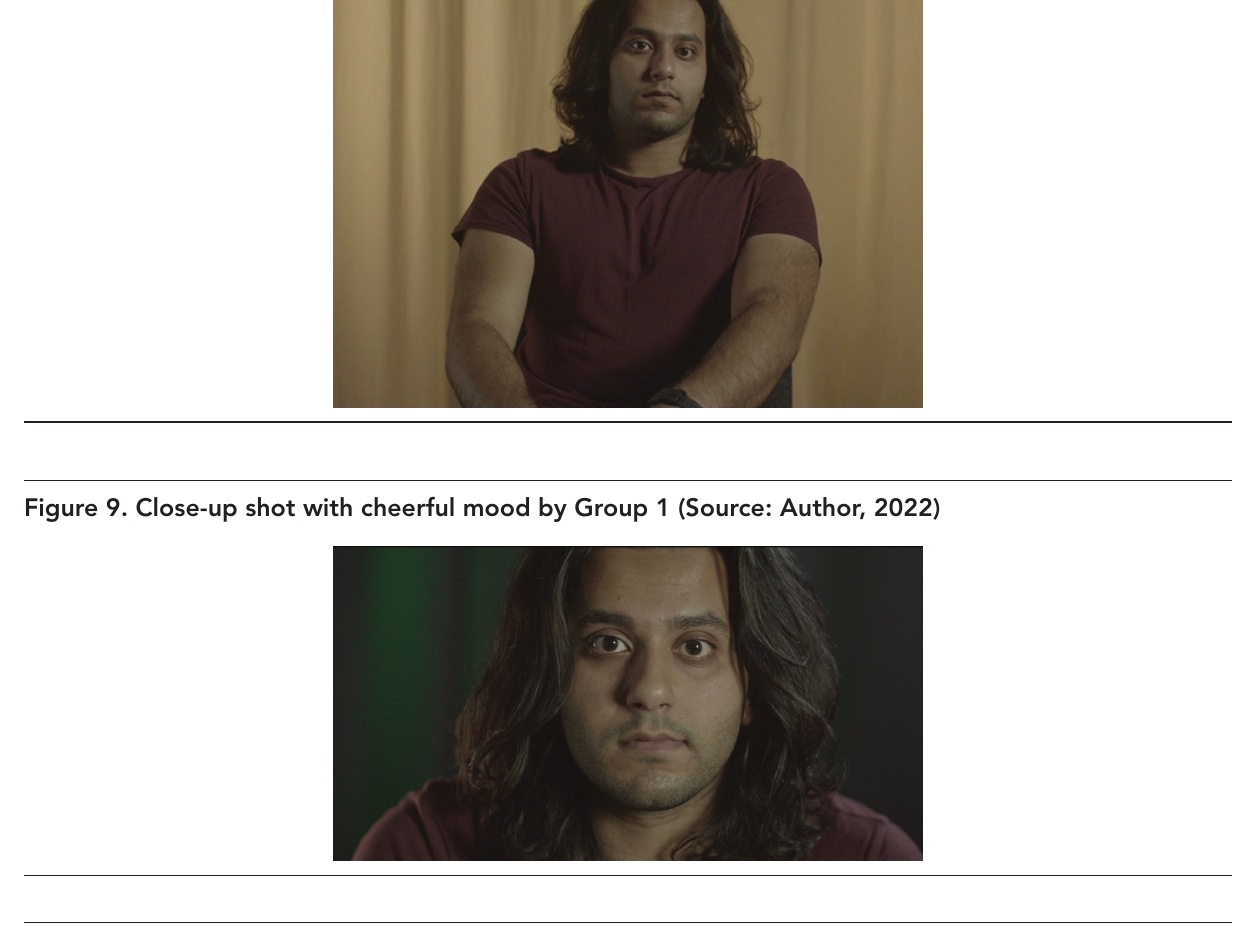
Figure 10. Medium shot with anxious mood by Group 1 (Source: Author,